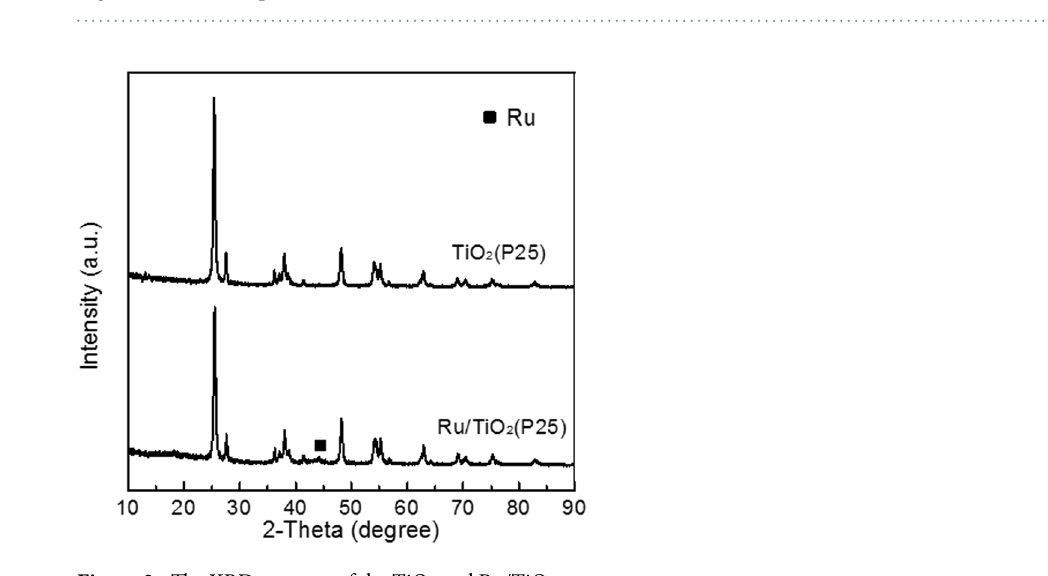
Figure 1. The XRD patterns of the TiO 2 and Pt/TiO 2 .